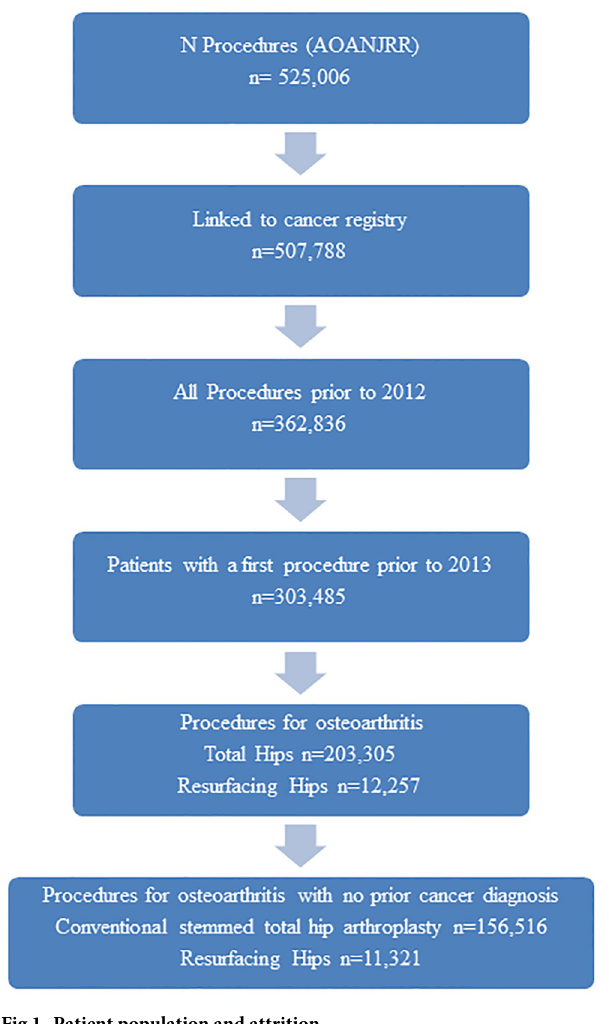
Fig 1. Patient population and